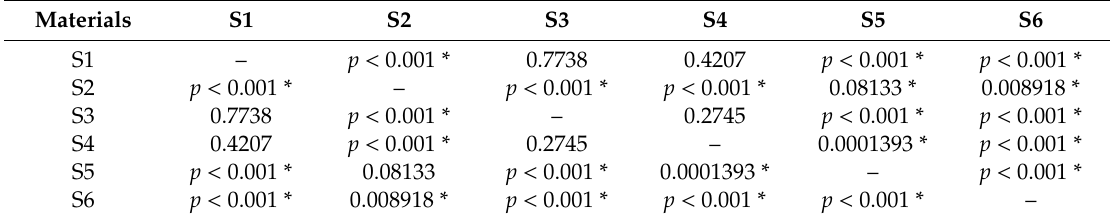
Table 5. Di ff erences in ∆ E after 168 h immersion in co ff ee with